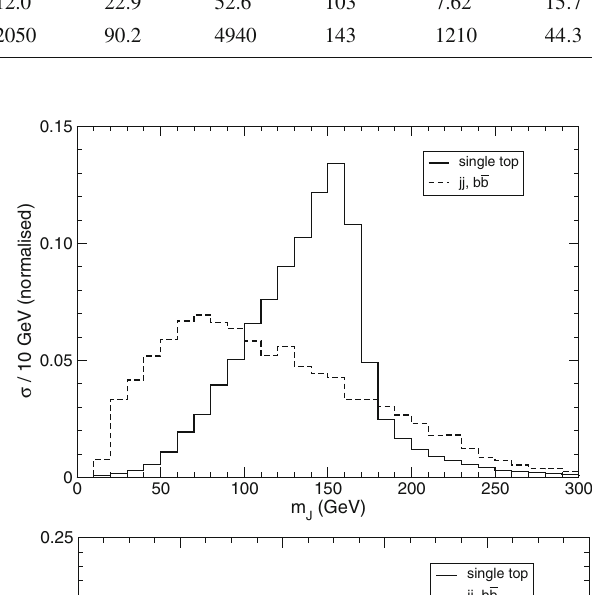
Fig. 2 Normalised distributions of the top jet mass (top) and τ 32 (bot- tom) for the single top signals and the dijet backgrounds, in the 1 b sample with the baseline selection